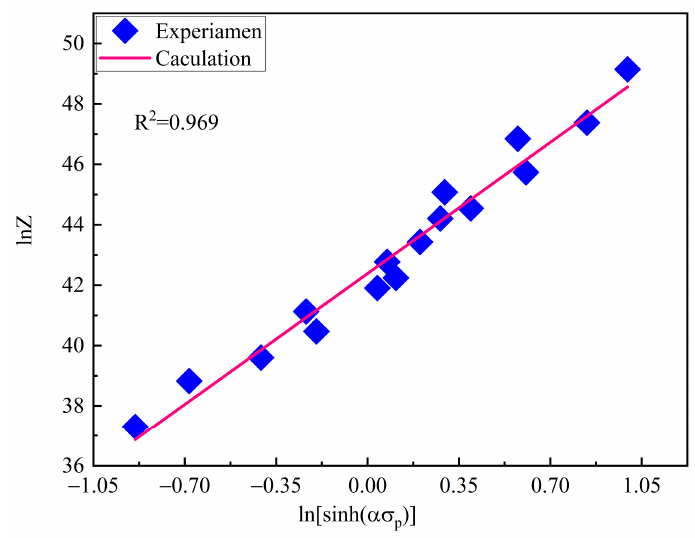
Figure 8. Relationship between the Z parameter and peak stress.